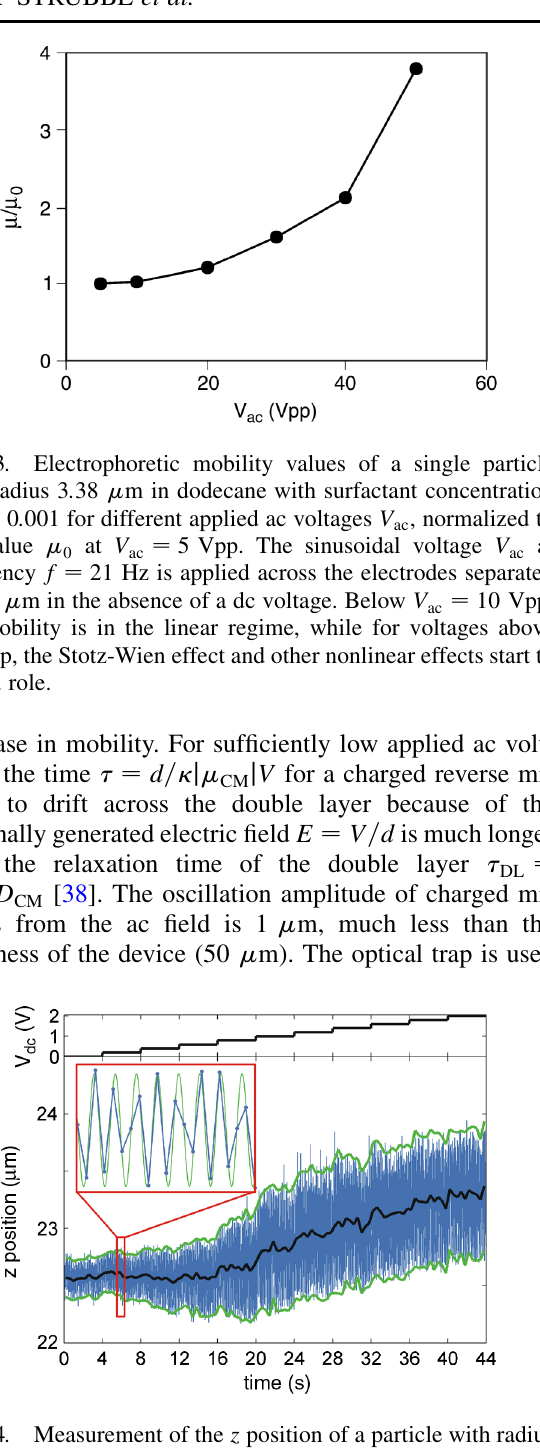
FIG. 4. Measurement of the z position of a particle with radius 3 : 38 (cid:1) m in a micellar-ionic electrolyte containing surfactant OLOA 11000 with mass fraction (cid:2) m ¼ 0 : 0004 in dodecane, sampled at 50 Hz. The particle is optically trapped in the z direction with trapping constant k z ¼ 3 pN =(cid:1) m , while a sinu- soidal voltage with f ¼ 21 Hz and V ¼ 10 Vpp superposed with a stepwise increasing dc voltage V dc is applied. For in-